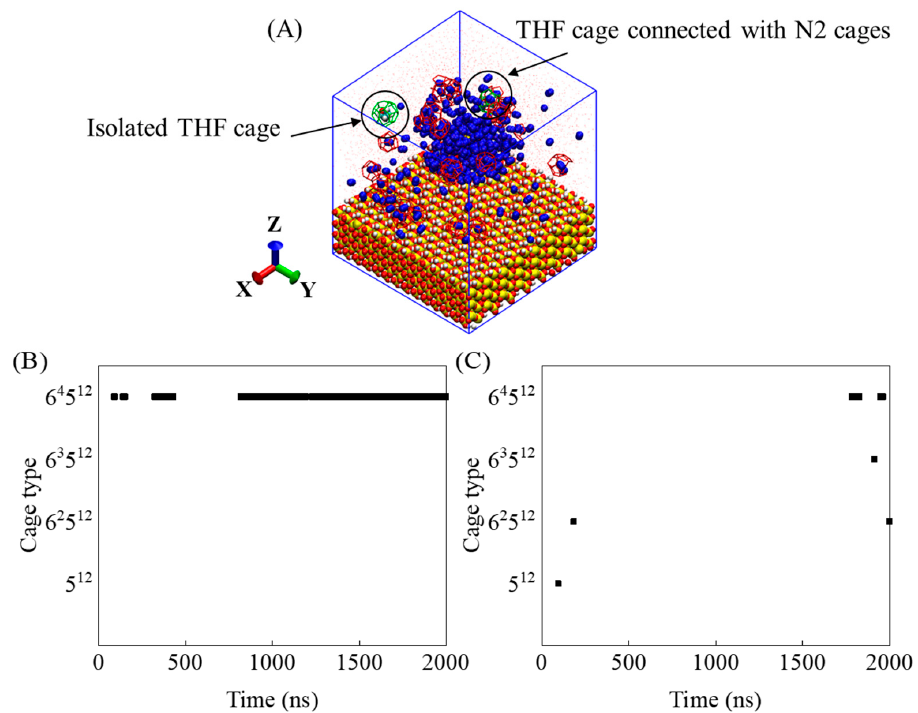
Figure 8. ( A ) Typical THF-filled cage connected with N 2 -filled cages and isolated THF-filled cage, and the evolution of the cage types of ( B ) THF-filled cage connected with N 2 -filled cages and ( C ) isolated THF-filled cage.